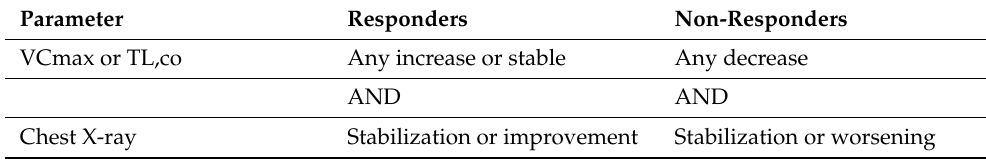
Table 1. Therapy outcome categorization based on PFT and chest X-ray results. Parameter Responders Non-Responders VCmax or TL,co Any increase or stable Any decrease AND AND Chest X-ray Stabilization or